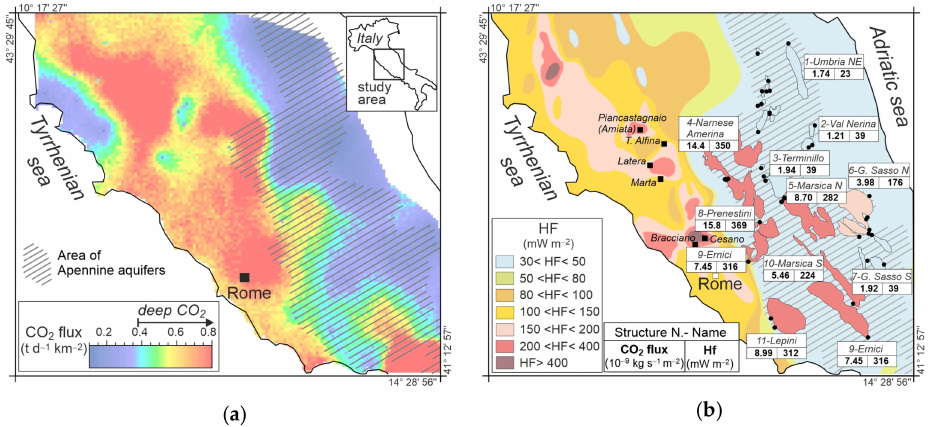
Figure 6. ( a ) CO 2 flux map of central Italy (modified from [17]); ( b ) Conductive heat flux map of central Italy ([43] modified from [17]). The location of the investigated aquifers and springs are reported together with the mean of the CO 2 flux and of the geothermal heat flux computed for each aquifer. Locations of the Latera and the Torre Alfina geothermal systems and of other geothermal wells are also shown. The area of Apennine aquifers is highlighted in both maps (dashed area).